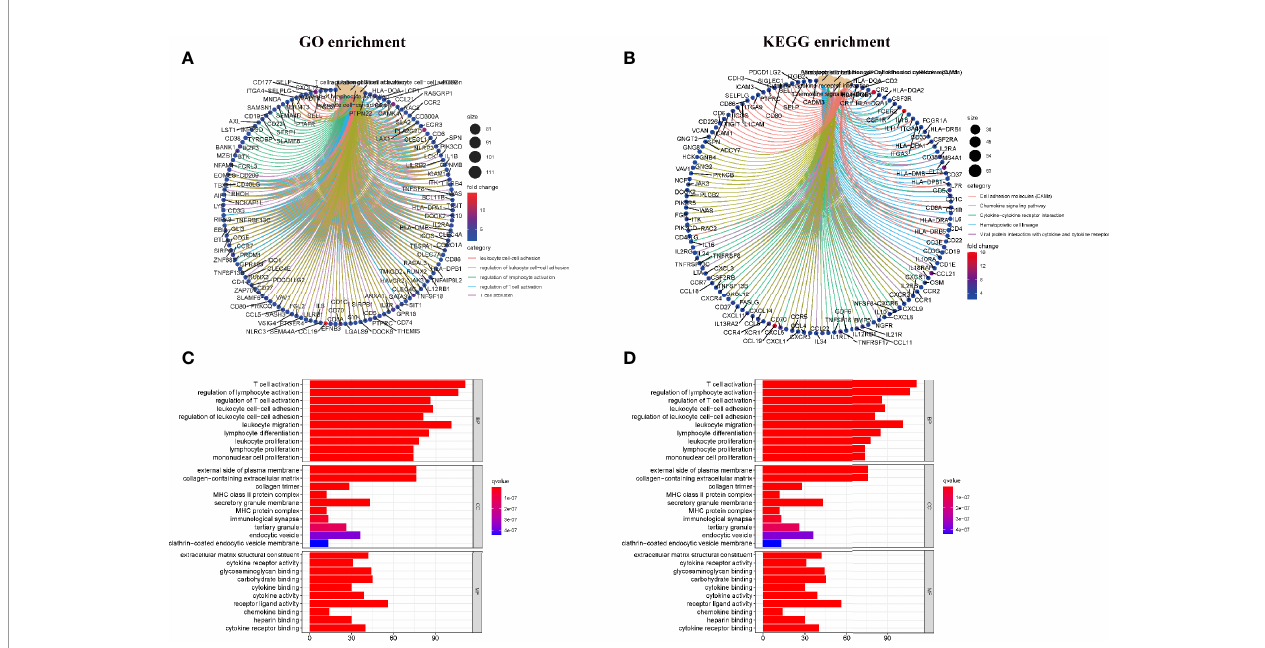
FIGURE 3 | Enrichment analysis of GO and KEGG for DEGs. (A, C) GO enrichment analysis for 830 DEGs; (B, D) KEGG enrichment analysis for 830 DEGs.